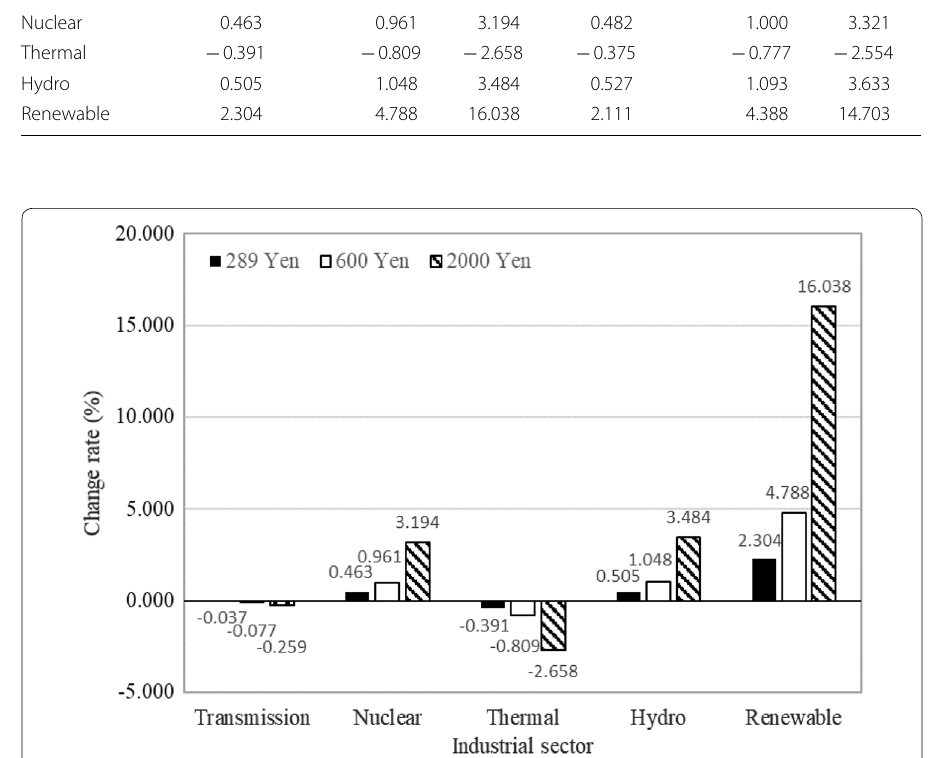
Fig. 3 The change rate of electricity generation in scenario 1